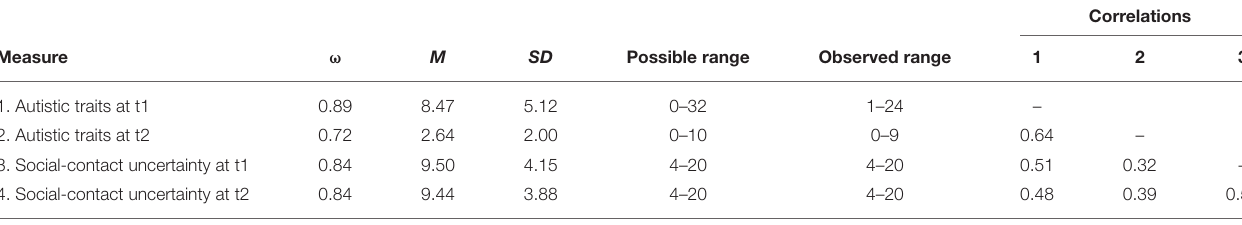
TABLE 1 | Descriptive statistics and correlations of the applied psychometric measures.